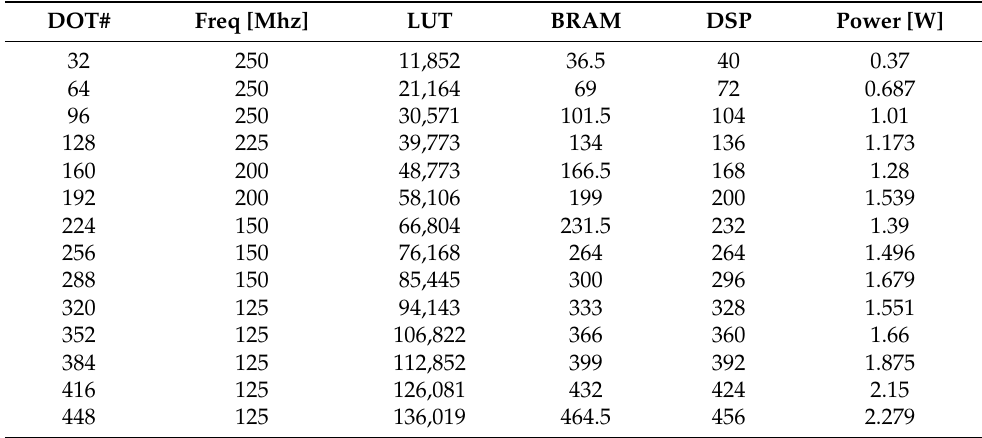
Table 5. SRMLC FPGA implementation